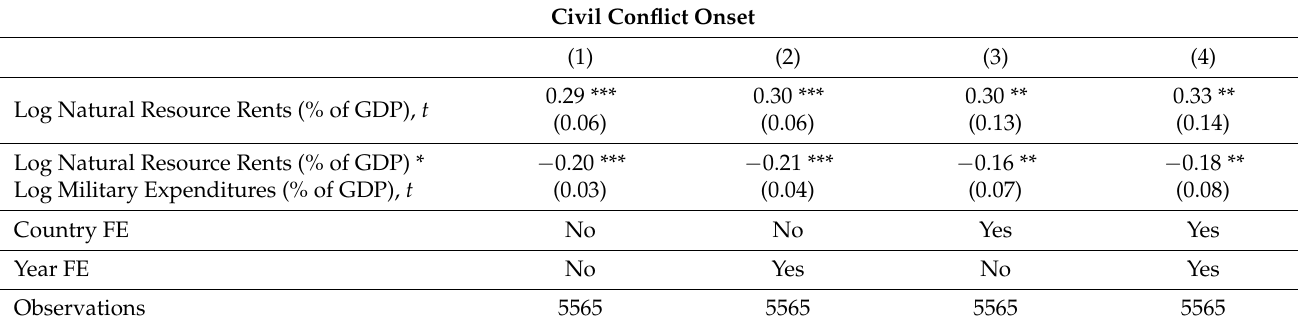
Table 2. Interaction Model with Log Military Expenditures % of GDP. Civil Conflict